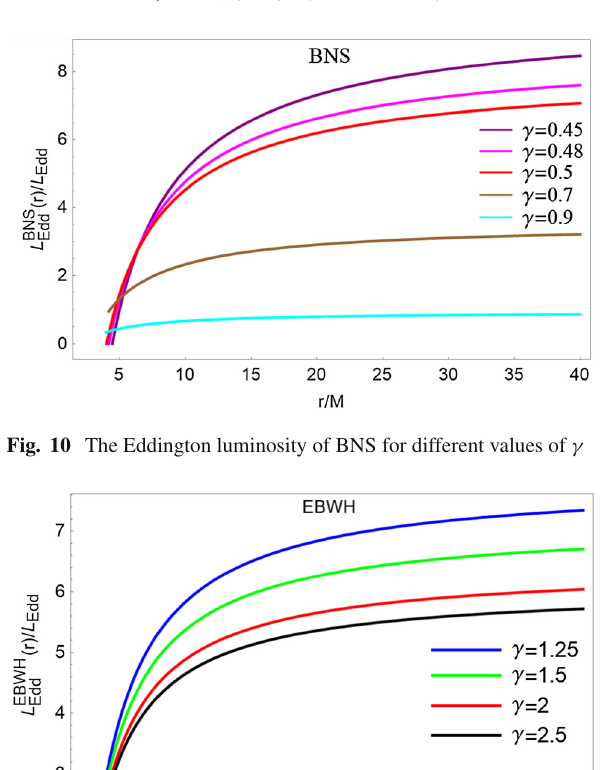
Footnote 5 continued differ, thus they are not invariant quantities, which is lucidly demon- strated in [89]. A precise lensing measurement can easily distinguish between the two theories, supporting one and ruling out the other. The basisforthisconclusionisthefundamentalfactthatordinarycoordinate transformations do not change curvature properties, while conformal transformations do change them leading to corresponding changes in